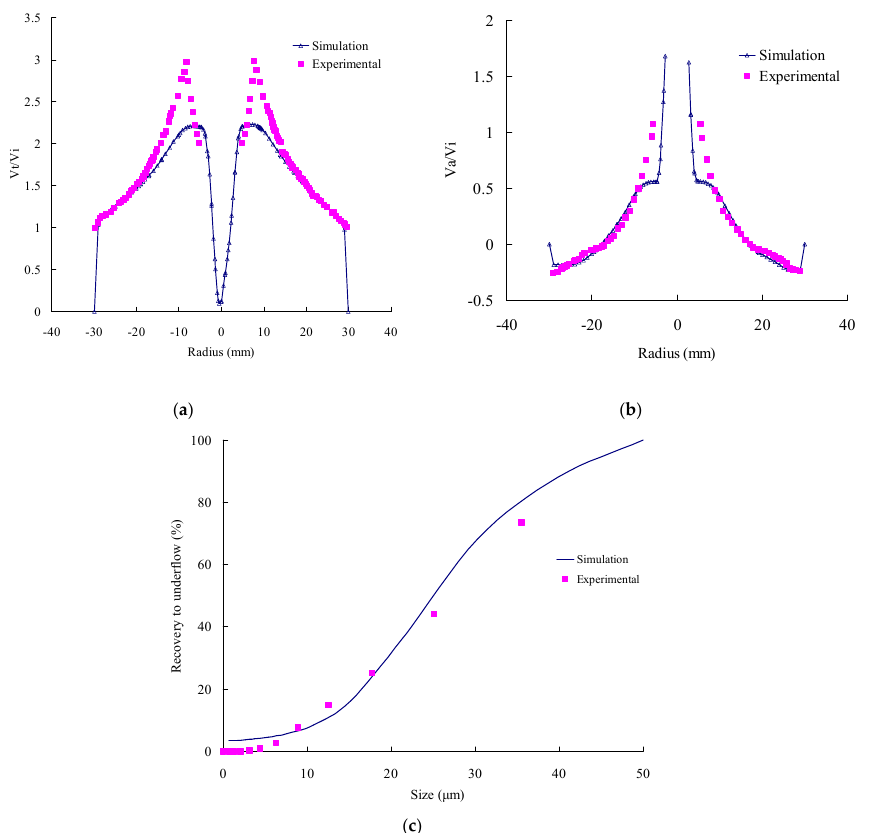
Figure 3. Comparisons between the simulation and the classic experiment: ( a ) tangential velocity (with Hsieh’s results [38]); ( b ) axial velocity (with Hsieh’s results); ( c ) comparison of separation behaviours (with Delgadillo’s results [3]).